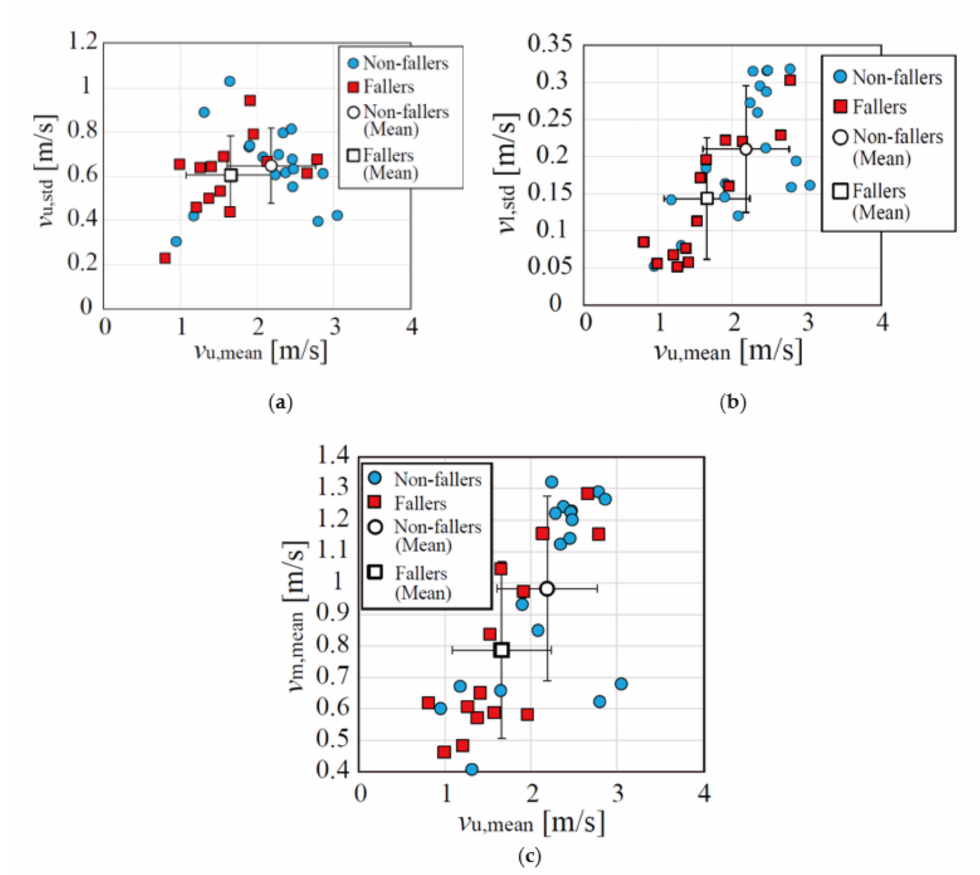
Figure 4. Gait parameters extracted from the experimental data. ( a ) v u,std vs. v u,mean ; ( b ) v l,std vs. v u,mean ; ( c ) v m,mean vs. v u,mean .